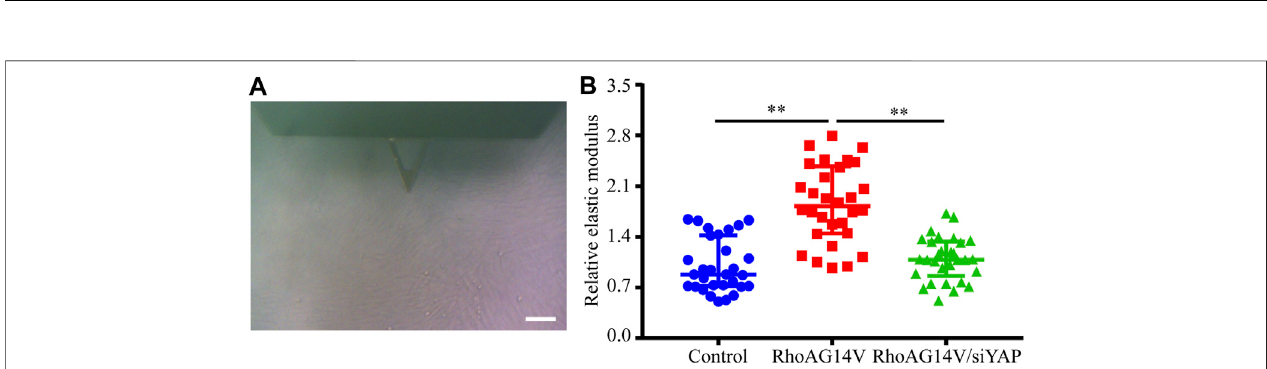
FIGURE9| siYAPdecreasedtheelasticmodulusofHTMcellscausedbyRhoAG14V(A)RepresentativeimageofindentationexperimentthatrepresentedtheAFM probe on the HTM cells captured by the inverted microscope. Black triangle, the cantilever of AFM; Scale bar, 100 μ m (B) The elastic modulus of HTM cells transfected with or without RhoAG14V and siYAP. ** p <